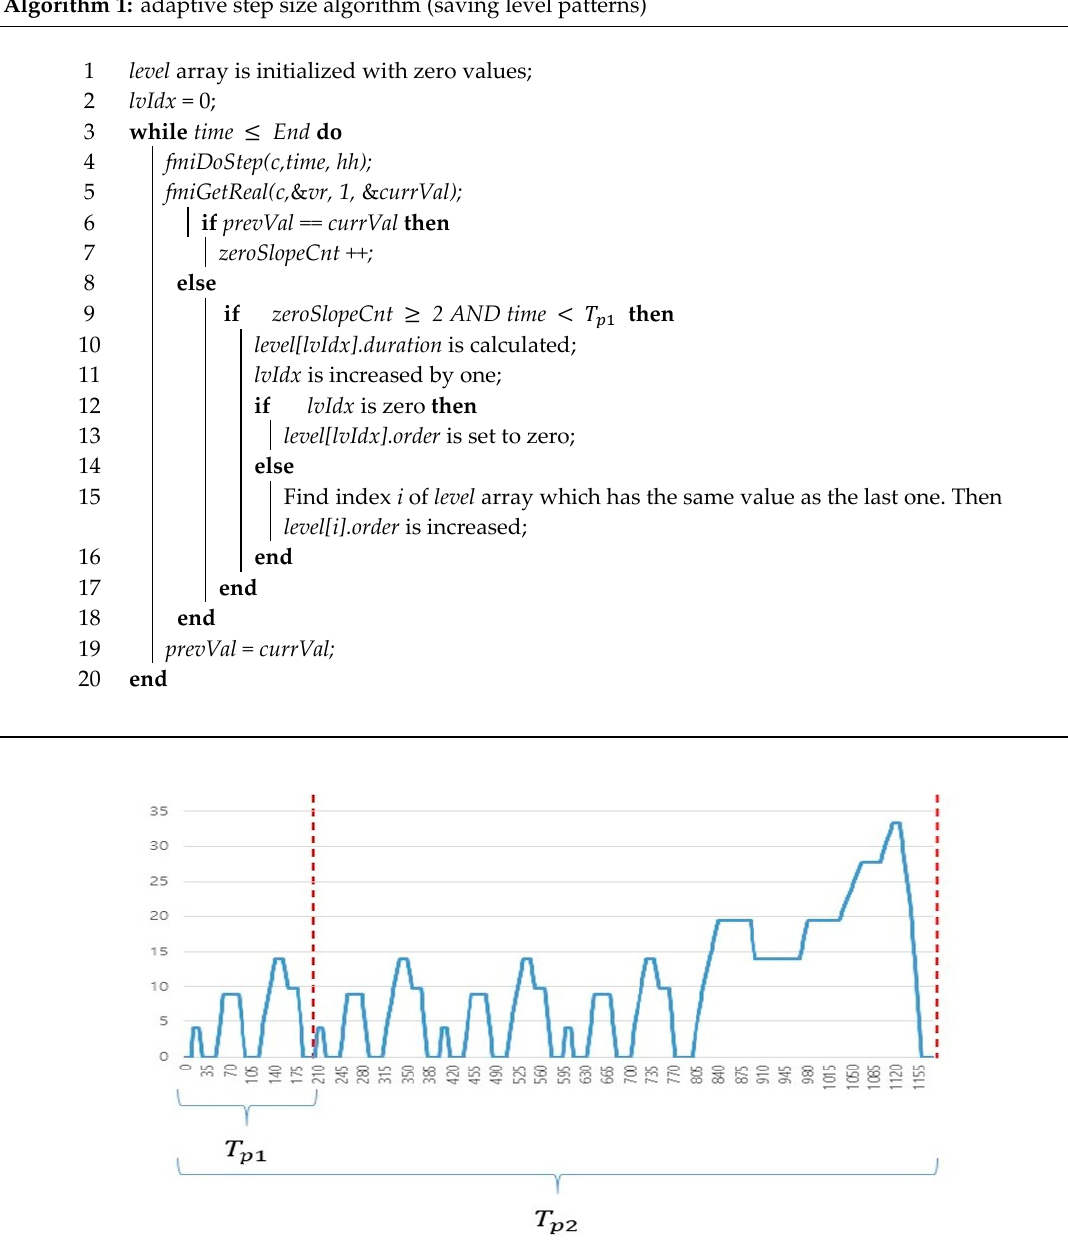
Figure 7. New European Driving Cycle (typical repetition cycle).